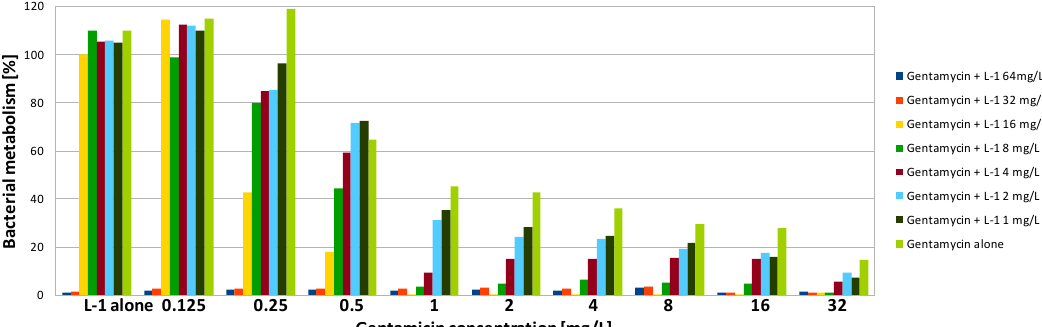
Figure 1. Activity of gentamicin in combination with lipopeptide 1 (L-1) against SA biofilm. Results presented as a percentage of metabolic activity in comparison to positive (100%) and negative (0%) controls; RSD ≤ 20%.